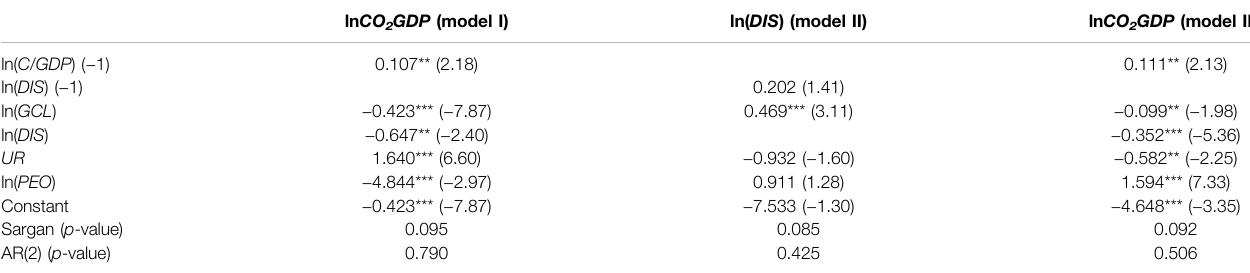
TABLE 5 | Robustness test results (provincial